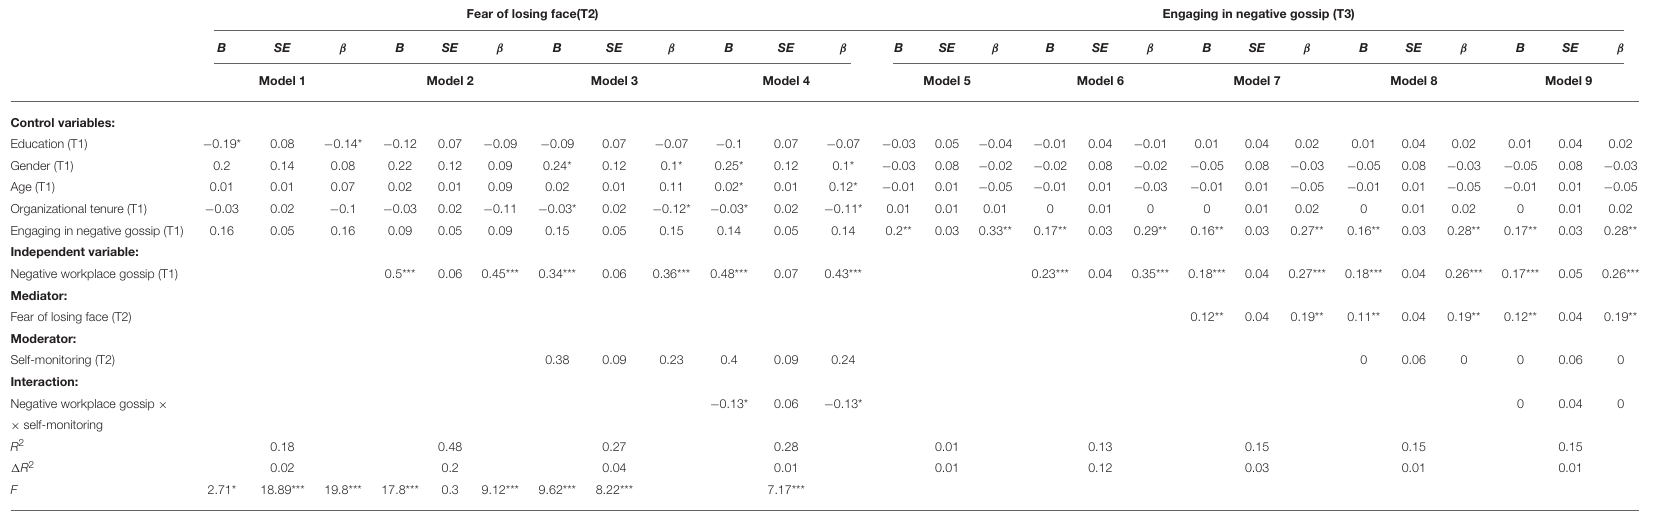
TABLE 3 | Results of hierarchical regression analysis.